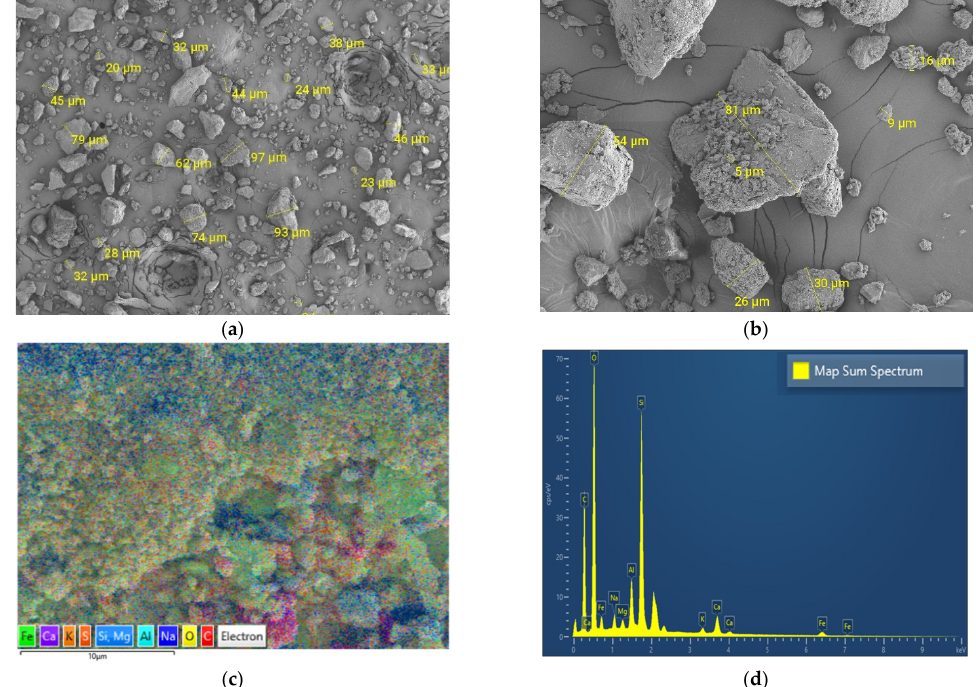
Figure 10. Scanning electron microscopy (SEM) image and energy dispersive X-ray spectroscopy (EDS) mapping analysis of PM. ( a ) SEM image of PM (200×), ( b ) SEM image of PM (1000×), ( c ) EDS elemental mapping, and ( d ) spectrum obtained by EDS. (EDS) mapping analysis of PM. ( a ) SEM image of PM (200 × ), ( b ) SEM image of PM (1000 × ), ( c ) EDS elemental mapping, and ( d ) spectrum obtained by